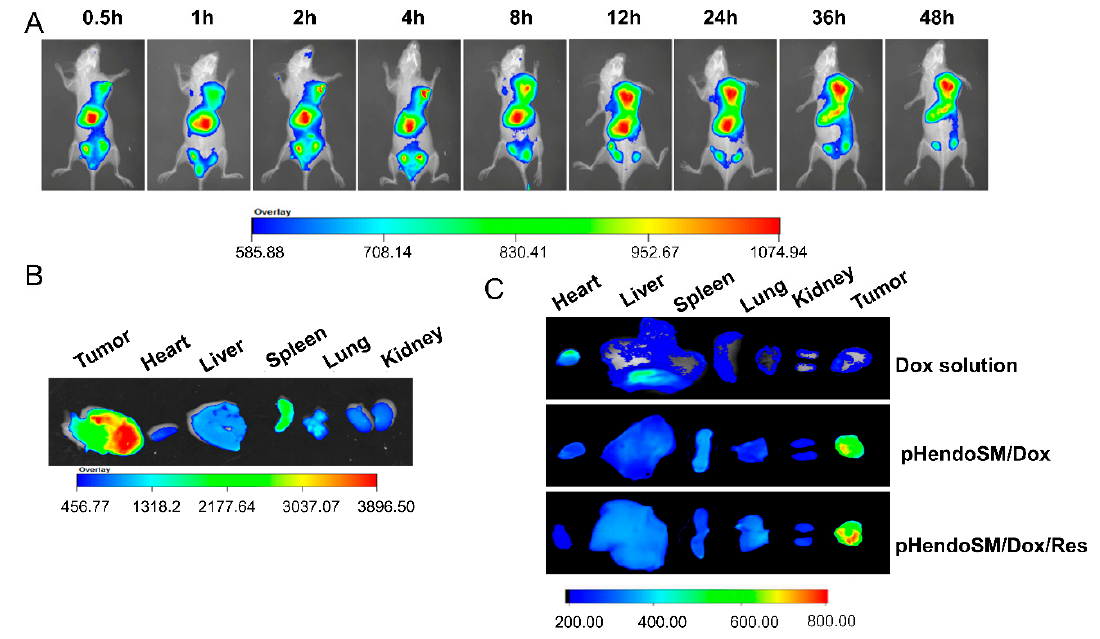
Figure 8. In vivo imaging of MCF-7 / ADR tumor-bearing nude mice after intravenous injection with DIR-loaded micelles ( A ), Ex vivo fluorescence images of tumors and organs collected at 48 h ( B ), In vivo distribution of Dox at 48 h after intravenous injected Dox solution, pH-endoSM / Dox, and pH-endoSM / Dox / Res ( C ) ( n = 3).